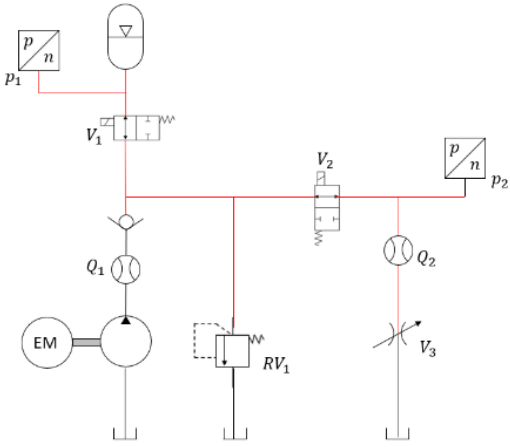
Figure 6. Hydraulic test bench during discharging mode.